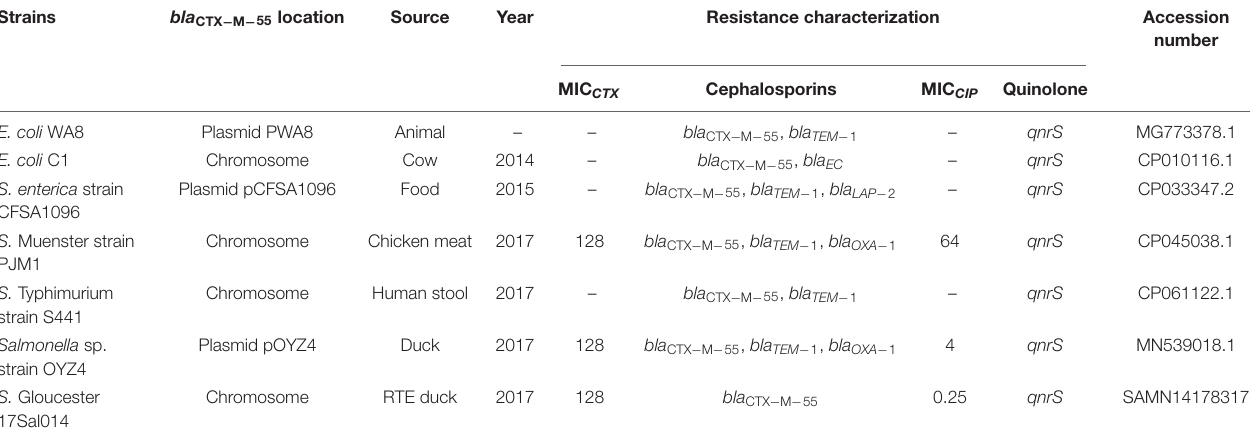
TABLE 1 | Characteristics of qnrS1 –IS 3 –Tn 3 – orf – bla CTX − M − 55 harboring isolates in China.